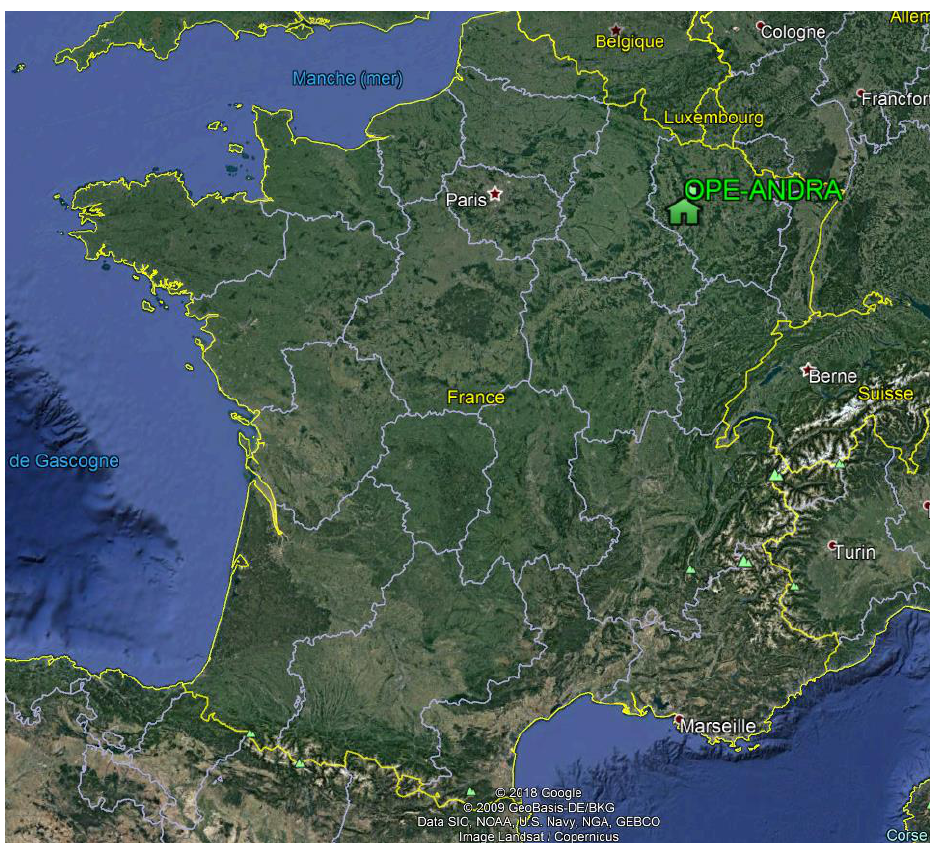
Figure 1. Map of France: The green house represents the Observatoire Pérenne de l'Environnement (OPE) station. (Adapted from Google Earth).